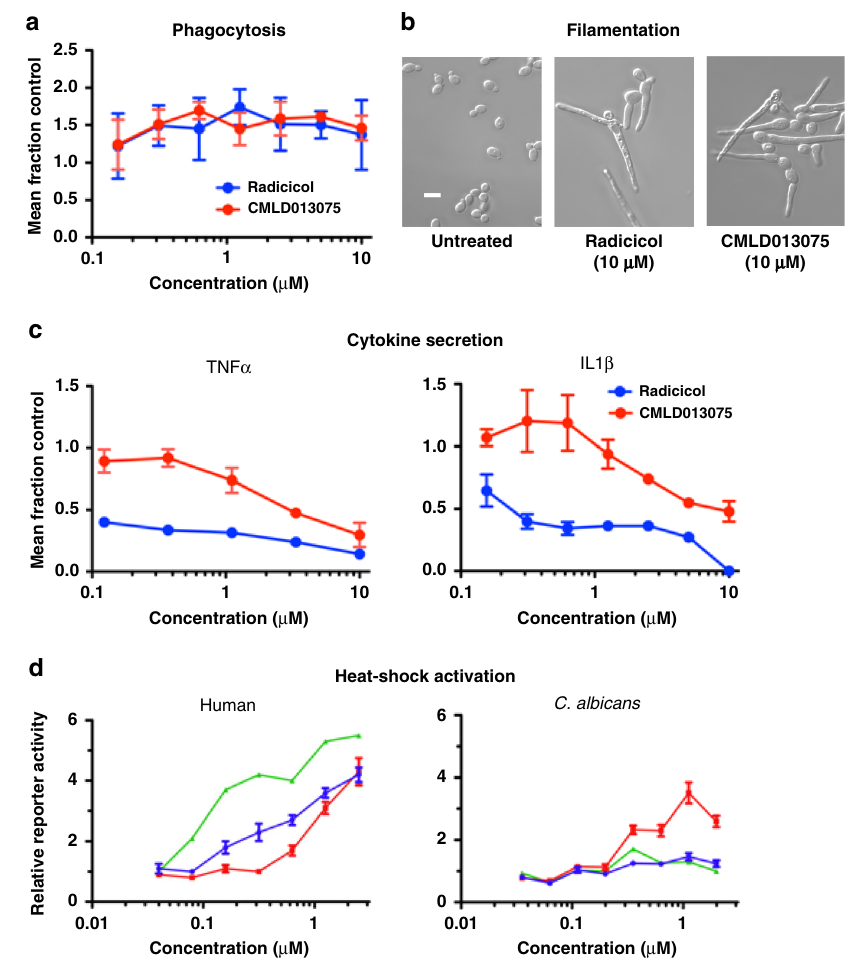
Fig. 7 Sparing of adverse effects on mammalian cells by CMLD013075. a Cultures of a mouse macrophage cell line were pre-incubated with the indicated concentrations of Hsp90 inhibitors, washed into compound-free medium and infected with a strain of GFP-expressing C. albicans . After an additional 2-h incubation, engulfment of fungus was monitored by fl ow cytometry. The percentage of macrophages with internalized C. albicans is plotted relative to no- compound control for increasing concentrations of inhibitor. Each data point represents the mean of triplicate determinations. Error bars, SD. The experiment was repeated as an independent biological replicate to con fi rm results. b Effect of Hsp90 inhibitor exposure on fungal fi lamentation, a well- established consequence of Hsp90 inhibition was imaged by differential interference contrast microscopy. Representative fi elds from micrographs obtained at the same magni fi cation for all images are presented. Scale bar, 10 µ m. The experiment was repeated as an independent biological replicate to con fi rm results. c Cultures of a mouse macrophage cell line were pre-incubated with the indicated concentrations of Hsp90 inhibitors, washed into compound-free medium and infected with a strain of GFP-expressing C. albicans . After additional 2-h incubation, aliquots of medium were removed and assayed by ELISA for level of the indicated pro-in fl ammatory cytokines. Each data point depicts the mean derived from three independent cultures. Error bars, SD. The entire experiment was repeated as an independent biological replicate to con fi rm results. d Induction of the heat-shock response was measured in a strain of C. albicans (right) and a mammalian cell line (left). Cells of each species were stably transduced with a plasmid encoding a reporter protein under transcriptional control of heat-shock promoter elements from an HSP70 gene native to the respective species. Relative concentration- dependent activation of reporter expression by compounds after overnight (human cells) or 6-h ( C. albicans ) exposure is plotted. Each point depicts the mean of three independent wells. Error bars, SD. The experiment in both human and fungal cells was repeated as an independent biological replicate